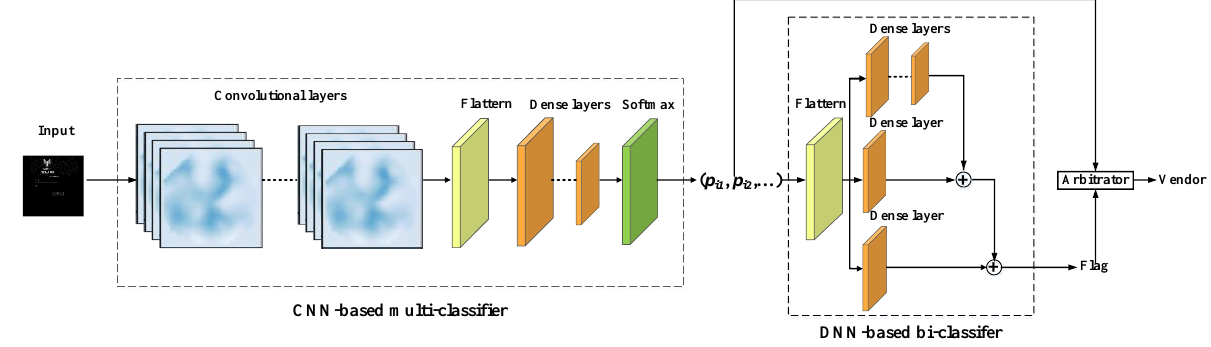
Figure 3. Device Vendor Classifying based on an ensemble model .